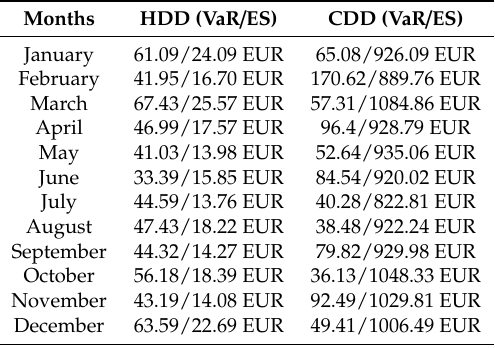
Table 5. Final prices (i.e., financial value + risk loadings) for HDD and CDD—simulations for been removed.